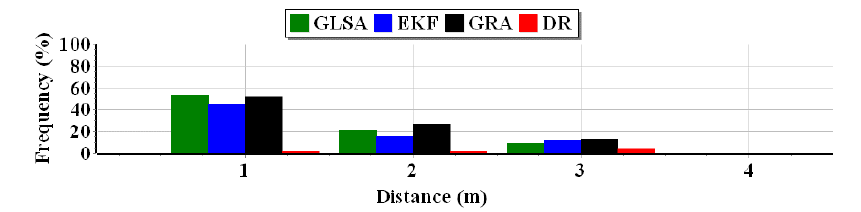
Figure 22. Percentage of distance to the reference point from the estimated point during a single SV crossing.